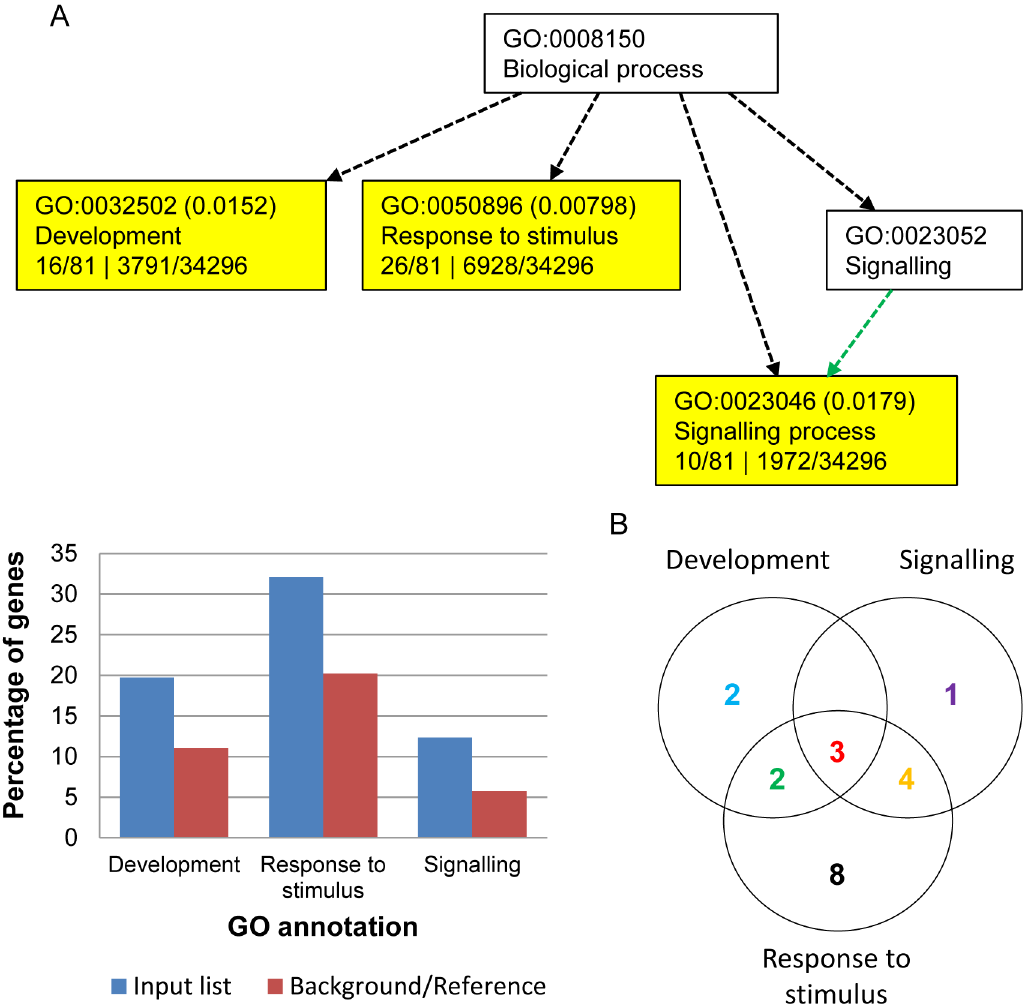
Fig 4. GO annotation of the target genes of drought-responsive miRNAs in IR87705-7-15-B. (A) The hierarchical graph and bar chart shows the over-representation of development, responseto stimulus and signallingprocesses when AGRIGO SingularEnrichment Analysis (SEA) was carried out on 94 predictedtargets of 27 miRNAs. (B) The Venn diagram displaysthe numericaldistribution of miRNAs with targets annotated to at least 1 of the over-represented